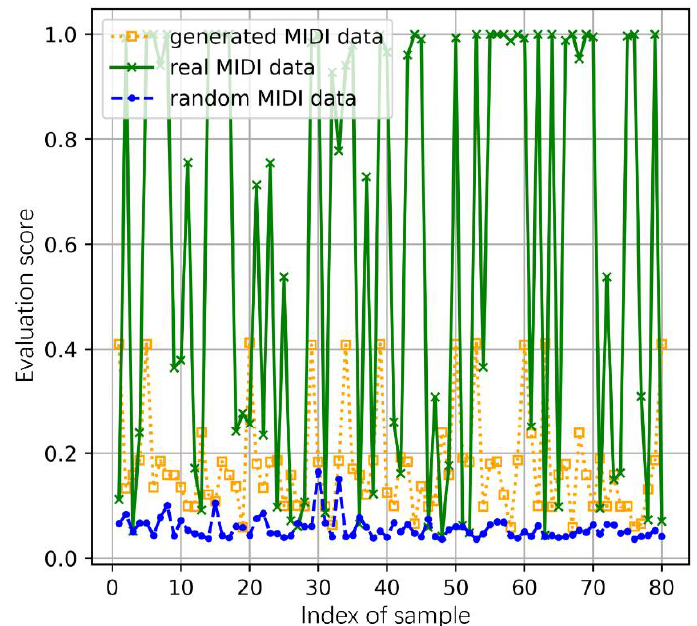
Figure 13. Evaluation scores of the proposed method by using real MIDI data, generated MIDI data, and random MIDI data.